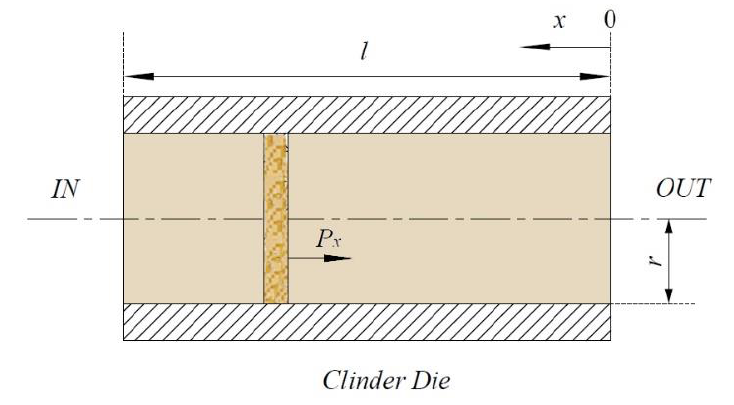
Figure 5. Schematic drawing of the pressure within the pressure channel of the